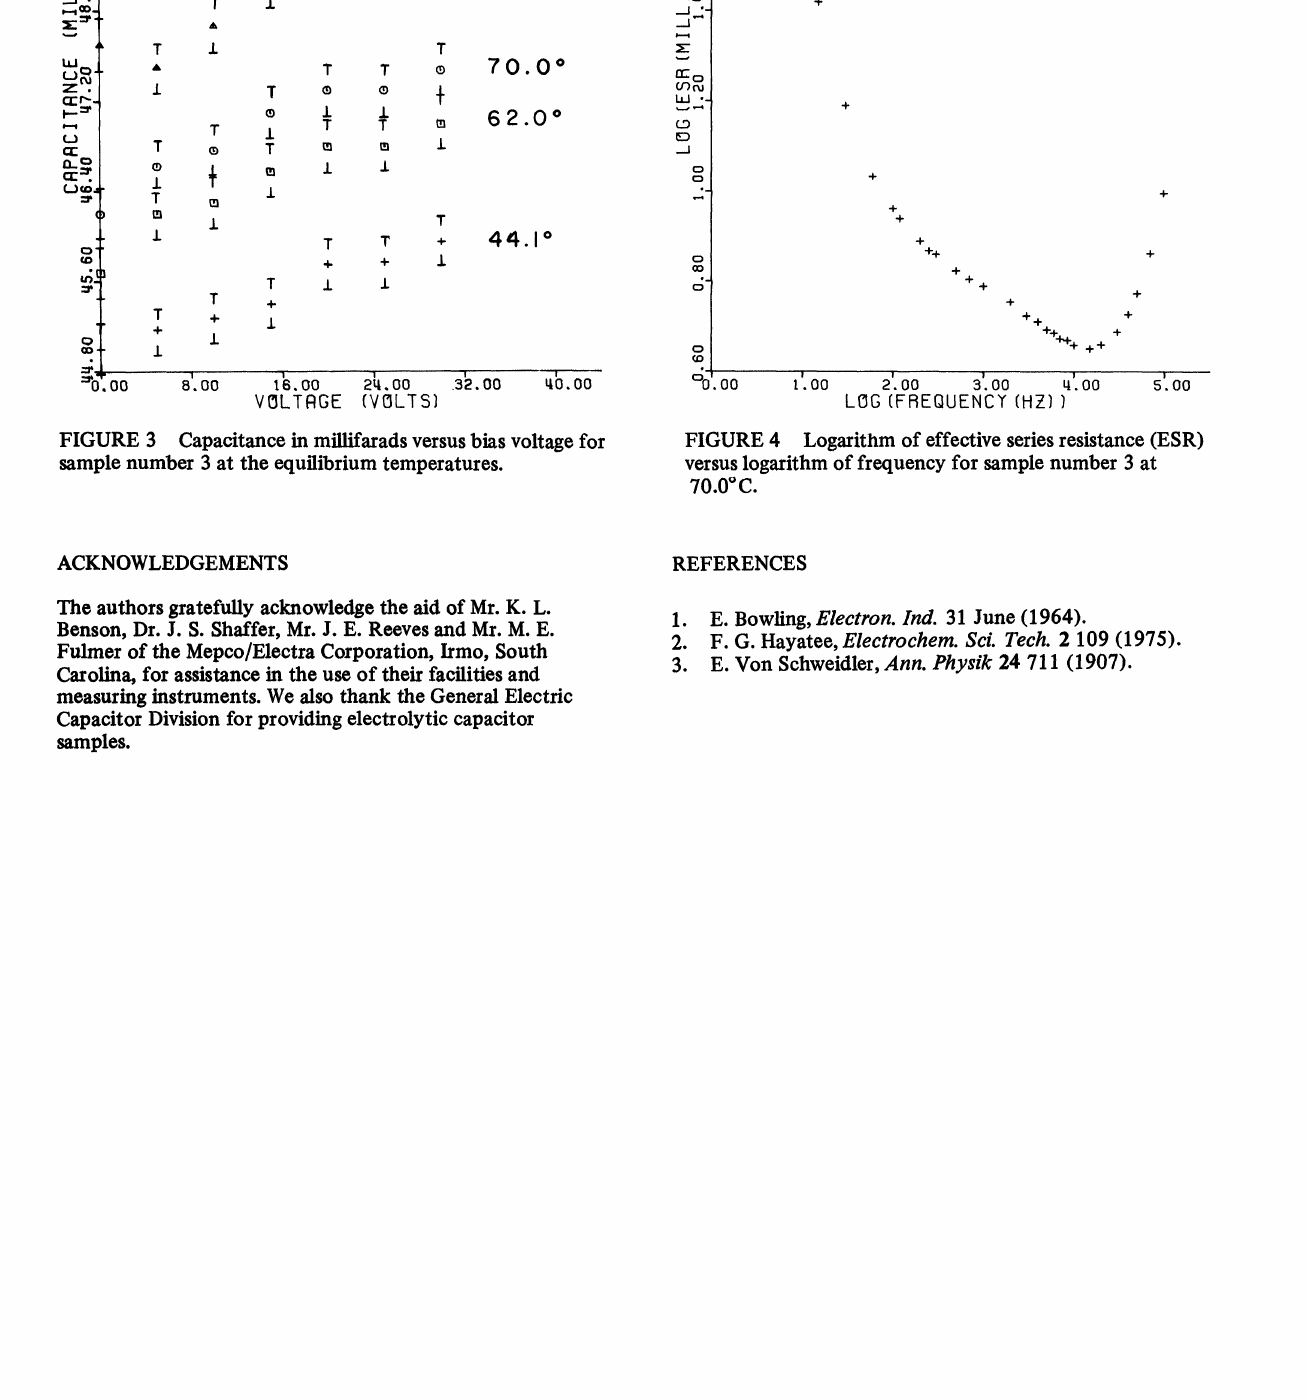
FIGURE 3 Capacitance in millifarads versus bias voltage for sample number 3 at the equilibrium temperatures.